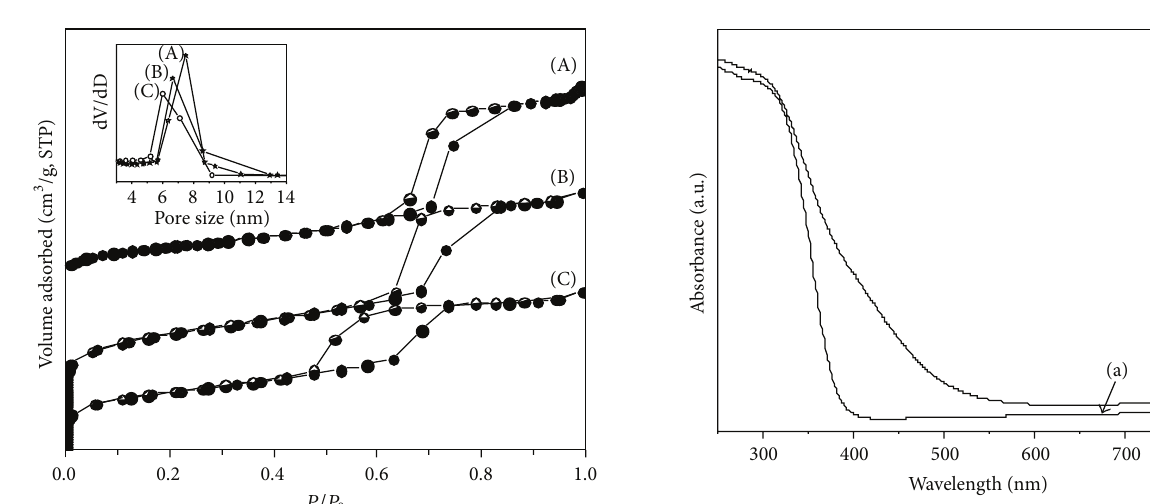
Figure 4: N 2 adsorption-desorption isotherms and pore size dis- tribution (the inset) of the pure SBA-15 (A), TiO 2 -SBA-15 (B), and N-TiO 2 -SBA-15 (C).